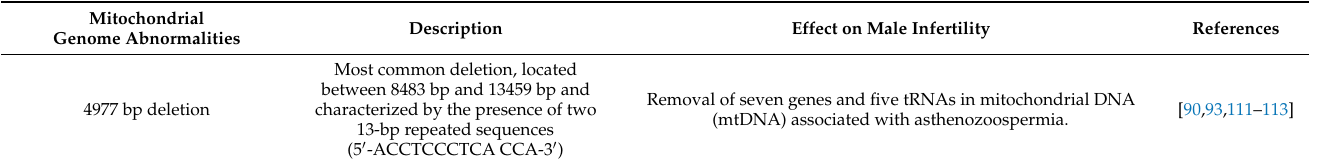
Table 2. Summary of studies reporting different mitochondrial genome abnormalities associated with male